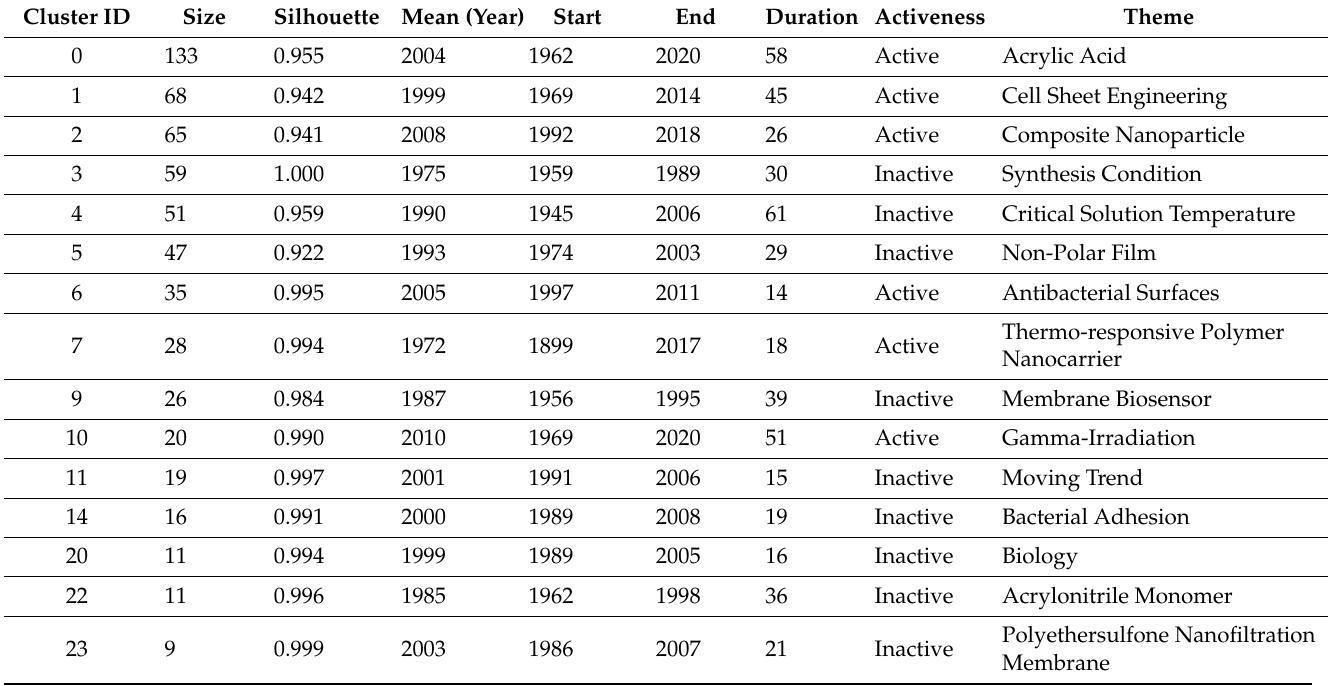
Table 7. Temporal properties of major